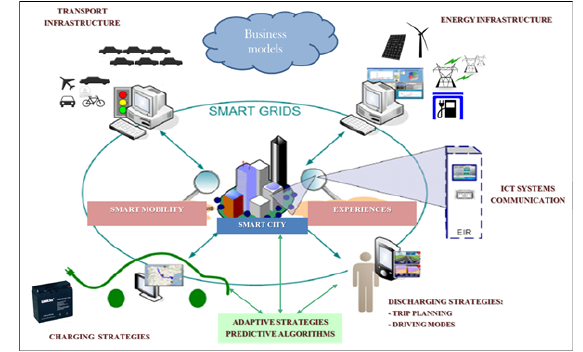
Figure 1. Elements of a Smart